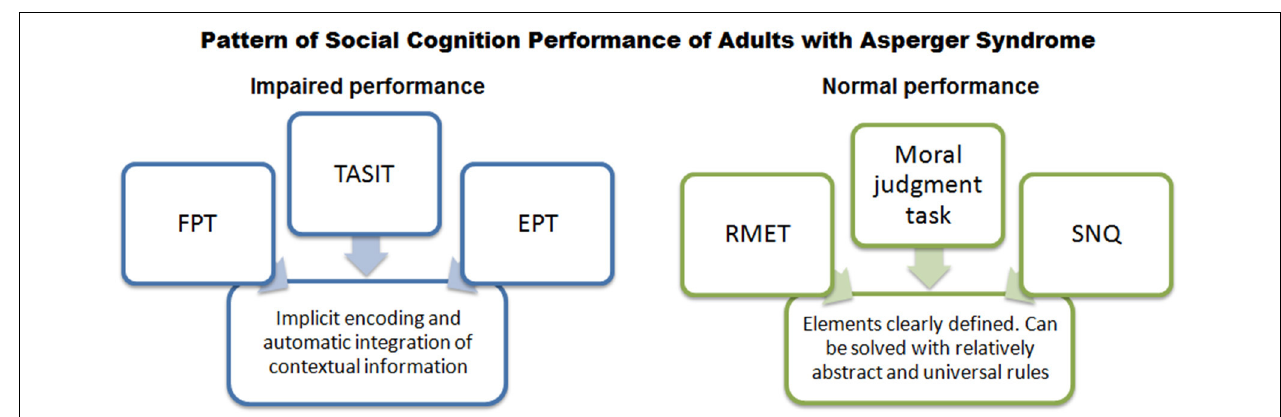
featured well defined-situational elements and could be solved by using relatively abstract, universal rules. FPT, Faux Pas Test; TASIT, The Awareness of Social Inference Test; EPT, Empathy for Pain Task; RMET, Reading the Mind in the Eyes Test; SNQ, Social Norms